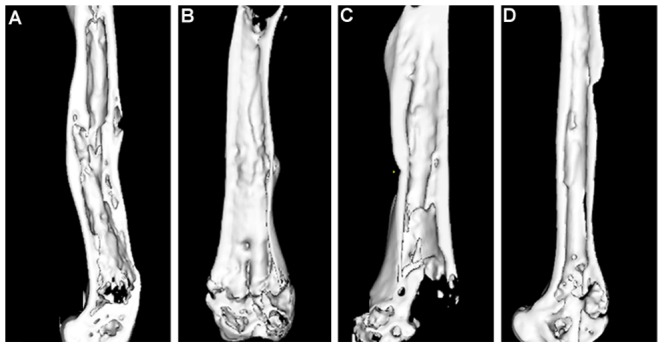
Representative micro-CT slices after 5 and 10 weeks of fracture healing in a control and a telmisartan-treated animal.A, C for the vehicle-treated group and B, D for the telmisartan-treated group.